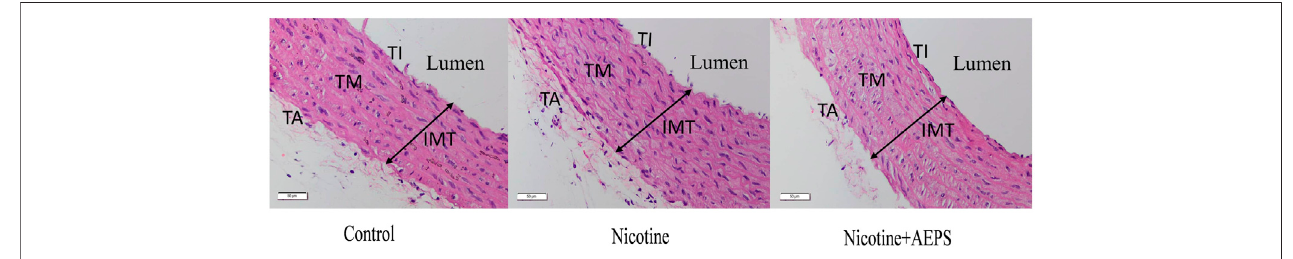
FIGURE 4 | Representative images of haematoxylin and eosin-stained sections of the aortic wall from each group of rats. Control and nicotine + AEPS groups showed normal histological appearance. The nicotine group displayed disorganized tunica media layer ( n (cid:1) 6-8 per group, × 400 magni fi cation, scale bar: 50 µm). IMT, intima-media thickness; TI, tunica intima; TM, tunica media; TA, tunica adventitia.